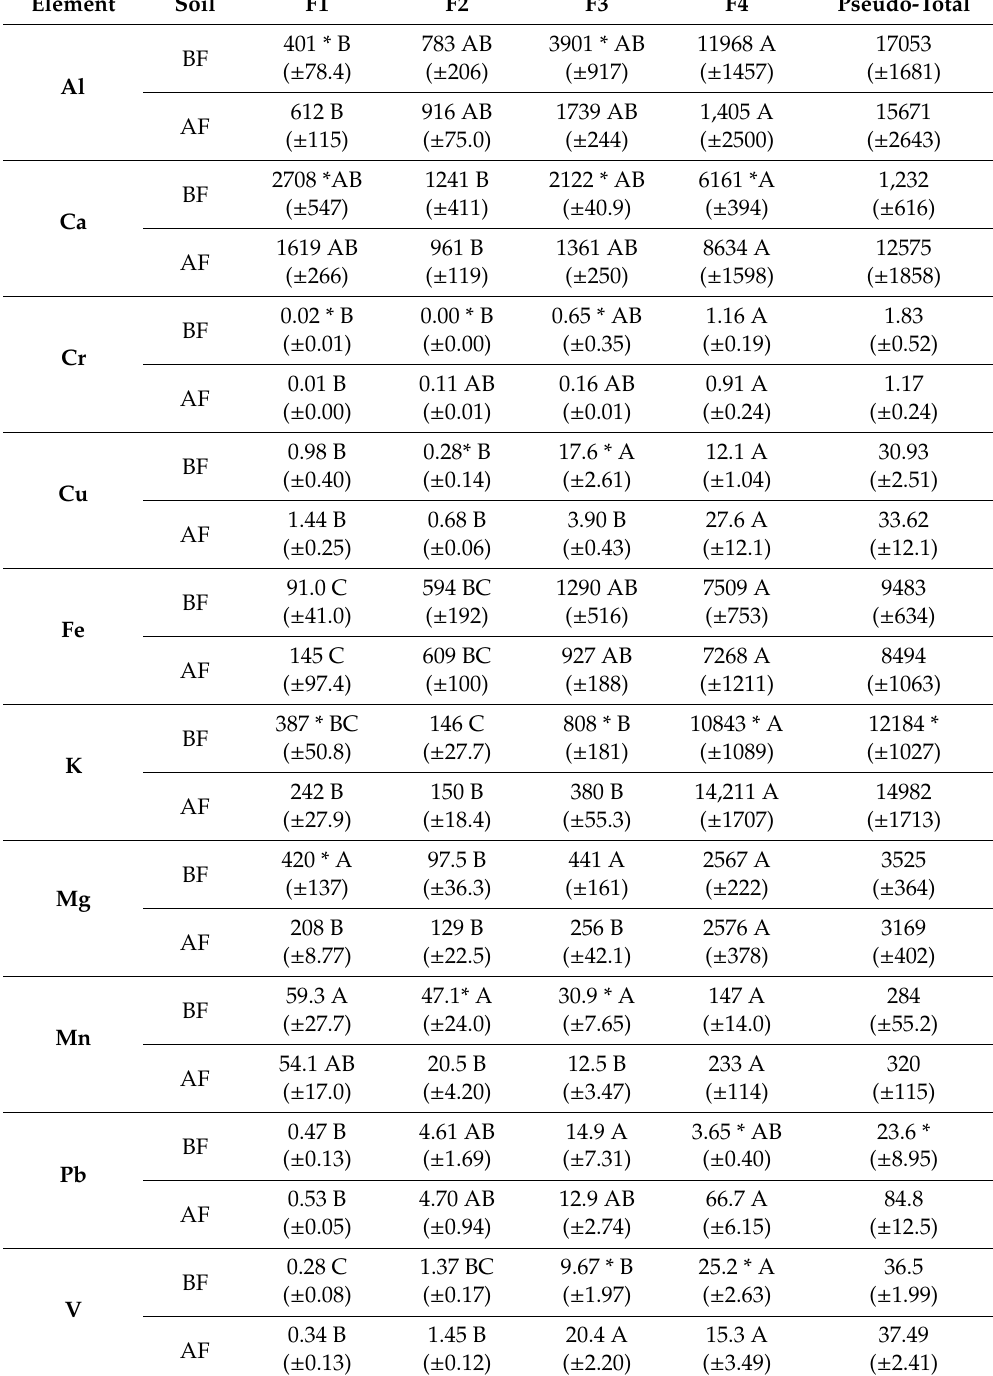
Table 2. Mean values ( ± s.e.) of the exchangeable (F1), reducible (F2), oxidizable (F3) and residual (F4) fractions of Al, Ca, Cr, Cu, Fe, K, Mg, Mn, Pb and V ( µ g g − 1 d.w.) in soils collected inside the Vesuvius National Park before (BF) and after (AF) fire occurrence. The sum of the contents of each element in the four fractions is reported as pseudo-total. The asterisks indicate significant di ff erences ( t -test, at least p < 0.05) of the element in each fraction and pseudo-total contents between BF and AF. Di ff erent uppercase letters indicate significant di ff erences (ANOVA, p < 0.05) among the fractions (F1, F2, F3 and F4) for each